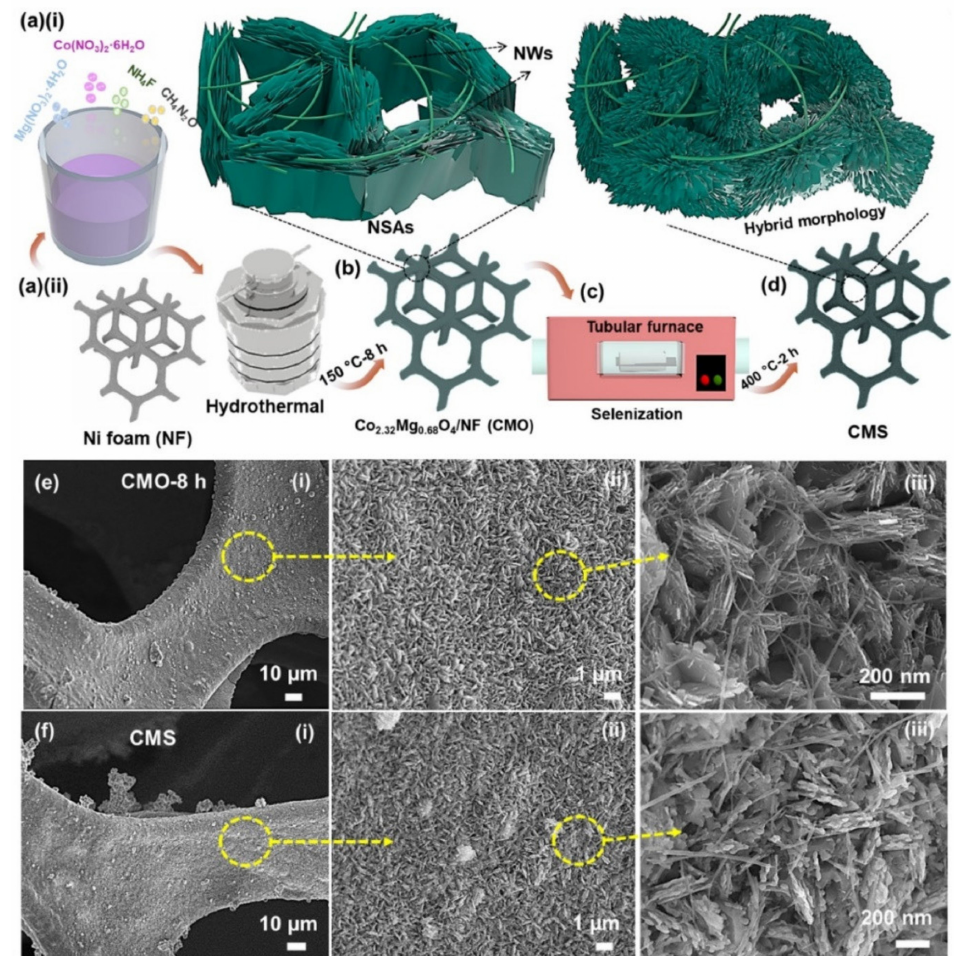
Figure 10. Schematic diagram for the preparation of the ( a , b ) cobalt–magnesium oxide − 8 h material with hybrid morphology and ( c , d ) cobalt–magnesium selenates material. FE-SEM images of the ( e ) cobalt–magnesium oxide − 8 h and ( f ) cobalt–magnesium selenates materials. Adapted with